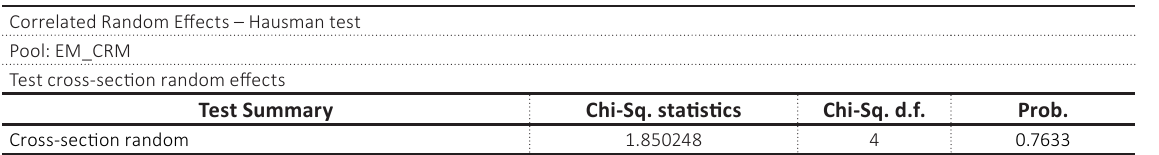
Table 7. Hypothesis